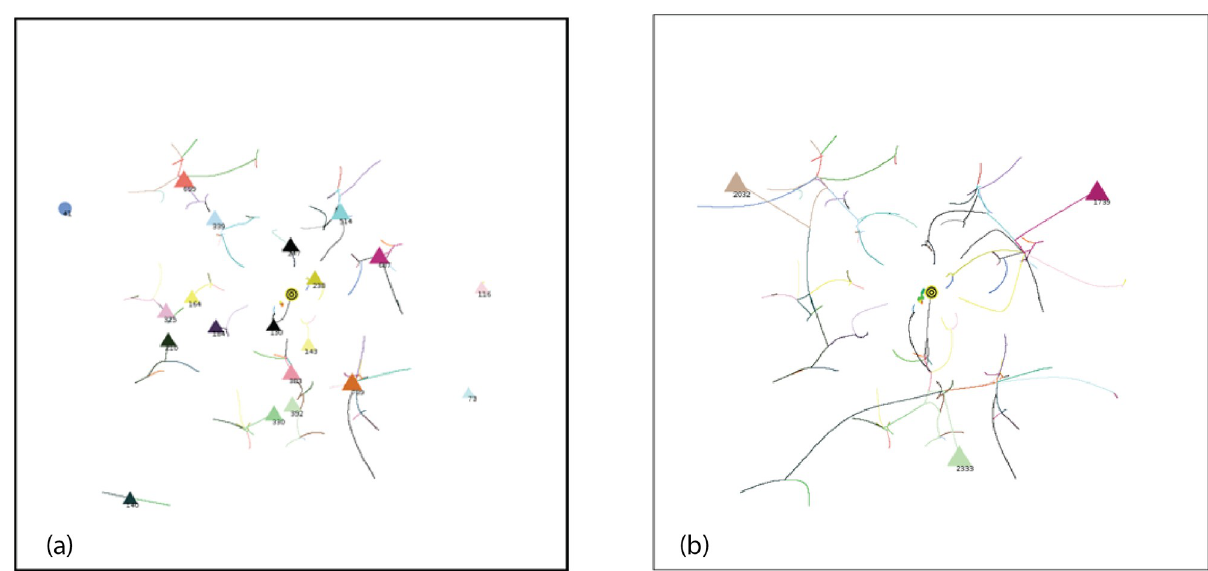
Fig 9. Simulation at 50% ET of completion. a) AIB = 30, ET = 3410, 1 individual, 19 groups, MDCN = 21, repulsive force < 0.8%, DT < 15. b) AIB = 180, ET = 27041, 3 groups, MDCN = 115, repulsive force � 100%, DT � 110.